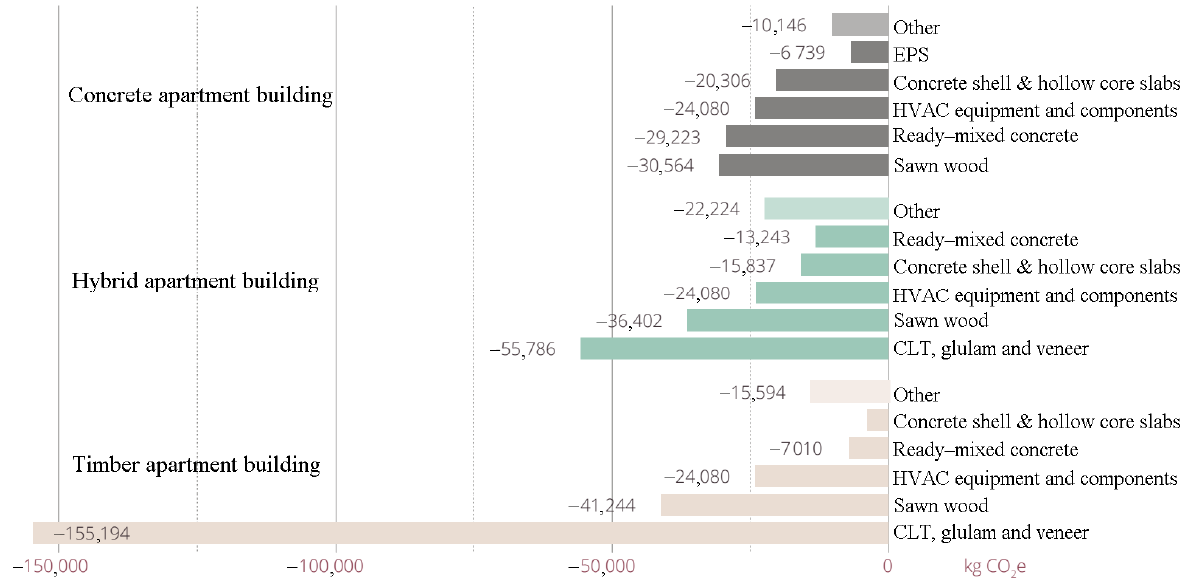
Figure 12. Distribution of carbon footprint by material in module D beyond the building life cycle. Reducing Carbon